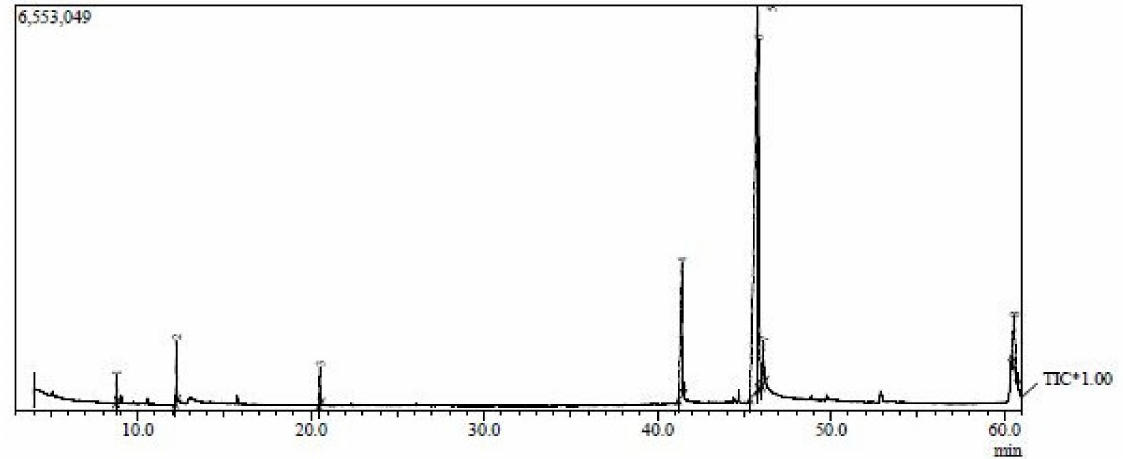
Scheme 2. G C-MS chromatogram of Nigella sativa Eos.